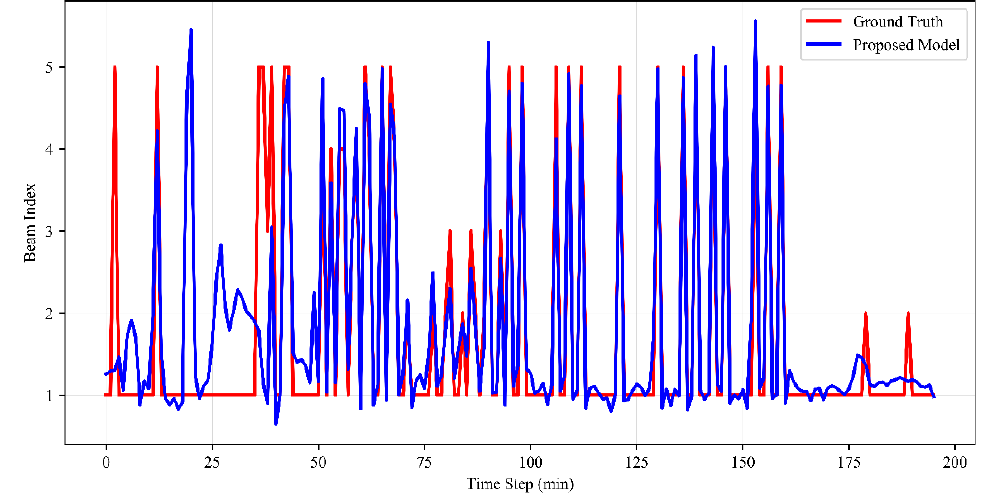
Figure 6. LSTM-based beam index prediction.